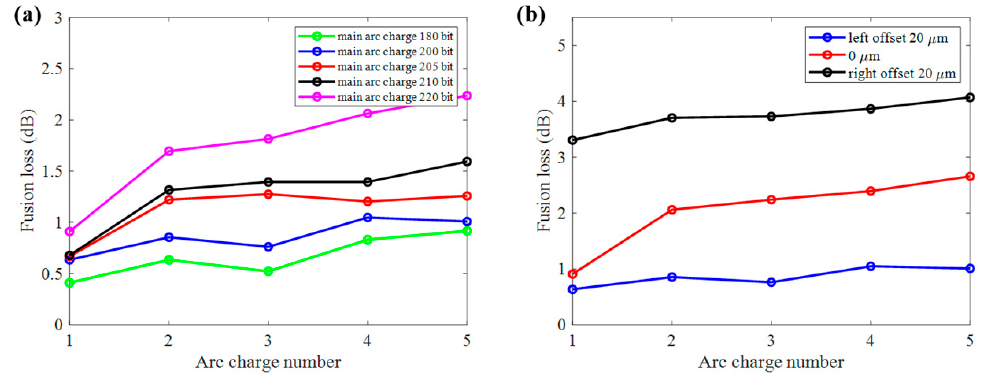
Figure 5. Splice loss measurement of the ( a ) main discharge intensities and times and ( b ) fiber offset and discharge times.